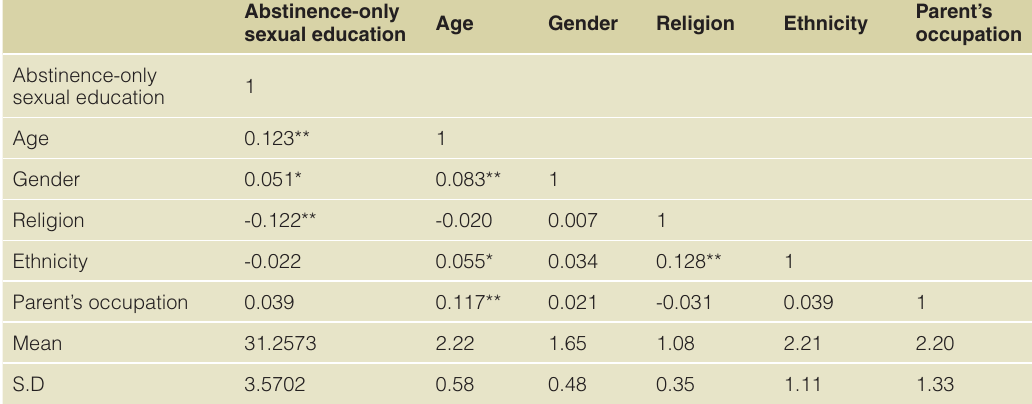
Table 15. Correlation matrix showing the relationship between perspective of abstinence-only sexual education and age, gender, religion, ethnicity and parent’s